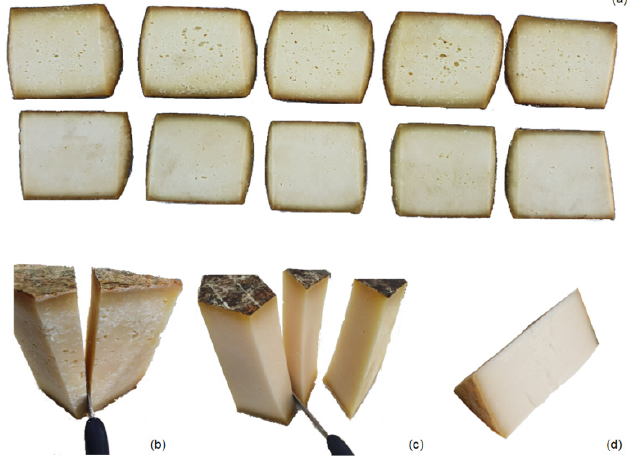
Figure 4. Representative images of the visual appearance of RC, HTC and industrial samples: Producer S1, Season 2, 105 days of ripening, Fiore Sardo from raw milk (upper row) and from heat-treated milk (lower row) ( a ); details of RC ( b ) and HTC ( c ) samples ripened 105 days upon cutting; industrial Fiore Sardo purchased from a local market, with at least 105 days of ripening ( d ). Even at first sight, RC, HTC and industrial cheeses appear very different from each other. The HTC samples surface appears more homogeneous, smoother and with